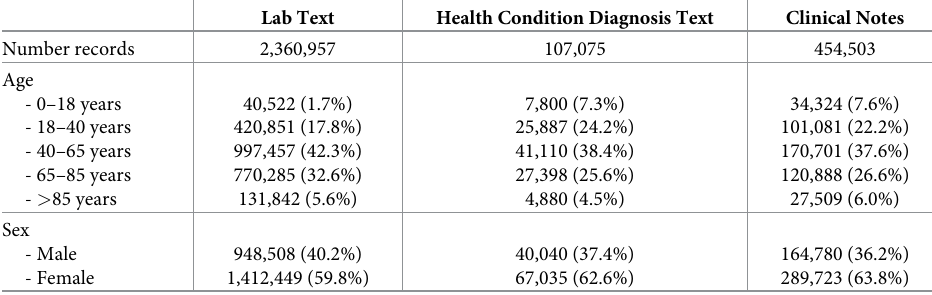
Table 1. Descriptive characteristics of lab texts, health condition diagnosis texts and clinical notes included in the study sample, measured on a record/encounter-level.